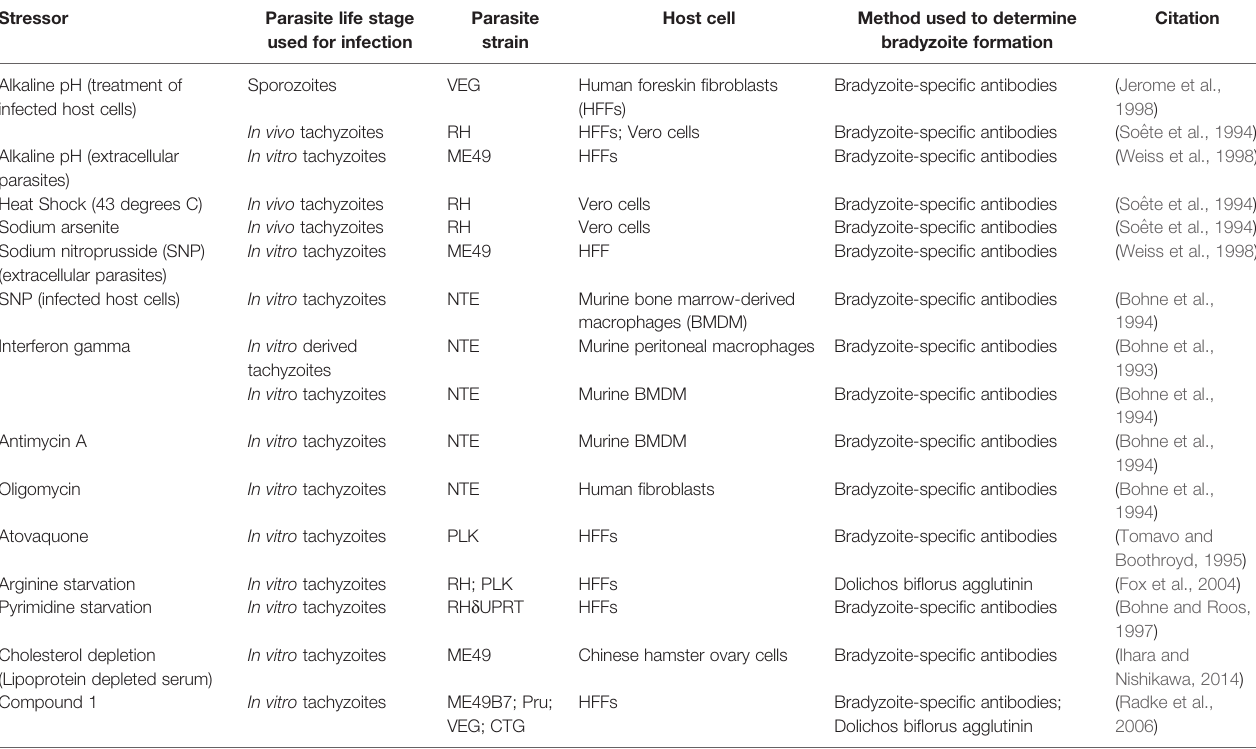
TABLE 1 | Summary of exogenous stressors that induce bradyzoite development in Toxoplasma gondii .